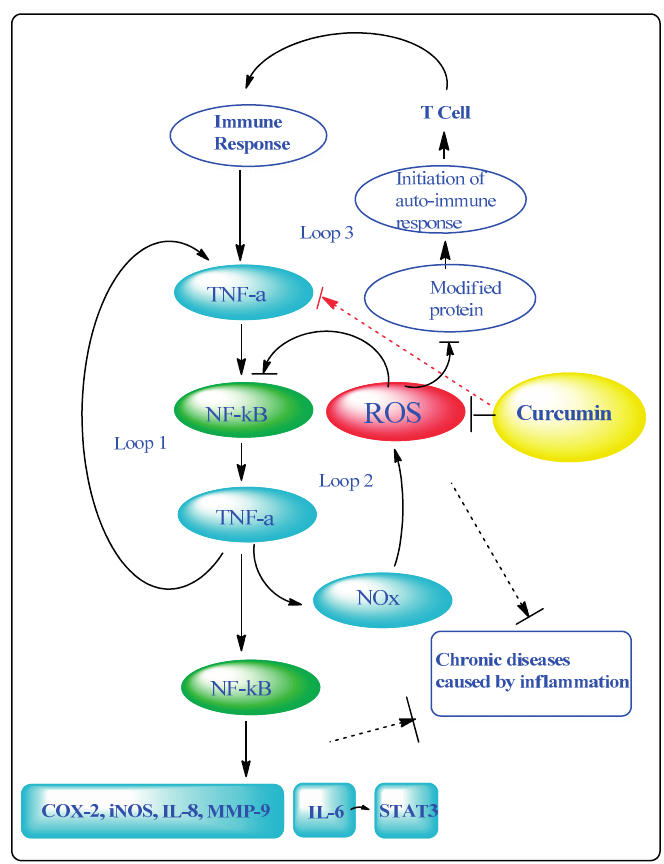
Figure 2. Relationship among ROS, chronic inflammation diseases and the antioxidative properties of